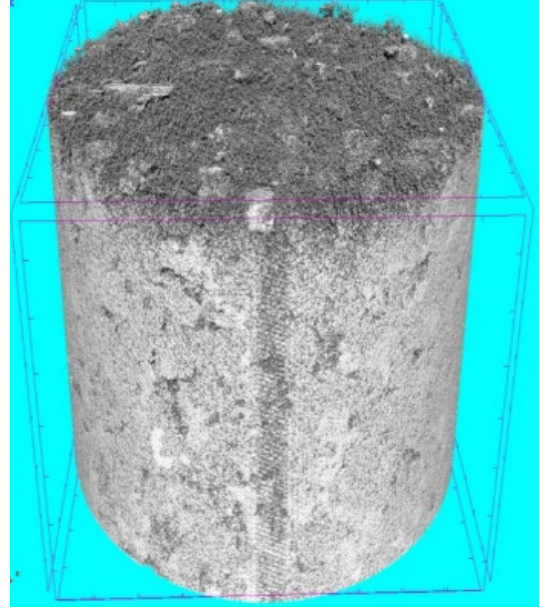
Figure 5. 3D real core model.